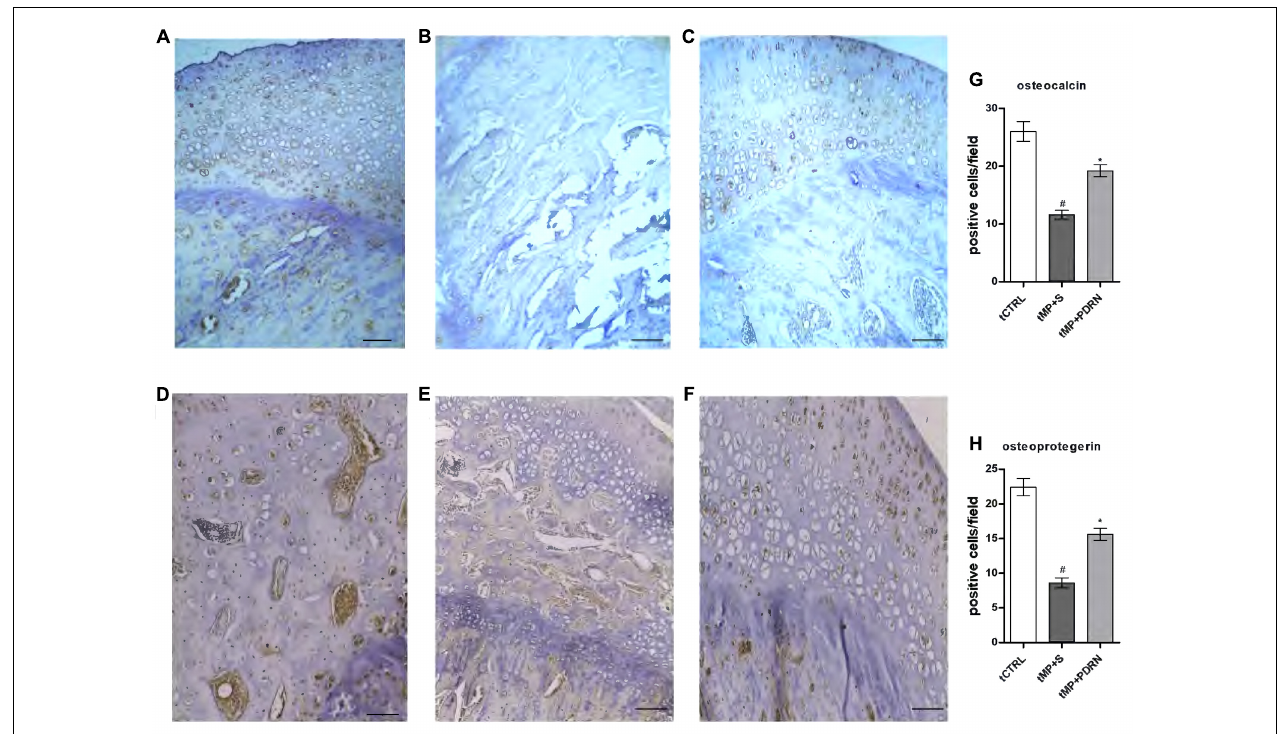
FIGURE 4 | Osteocalcin and osteoprotegerin immunostaining. (A–C) Representative osteocalcin immunostaining of femoral head sections, scale bar 10 µ m. Haematoxylin counterstain. (A) tCTRL, (B) tMP+S; (C) tMP+PDRN. (D,E) Representative osteoprotegerin immunostaining of femoral head sections, scale bar 10 µ m. Haematoxylin counterstain. (D) tCTRL, (E) tMP+S; (F) tMP+PDRN. (G,H) The graphs represent the number of positive cells for osteocalcin (G) and osteoprotegerin (H) , per high power field. ∗ p < 0.05 vs. tMP+S; # p < 0.05 vs. tCTRL. Data are expressed as means and